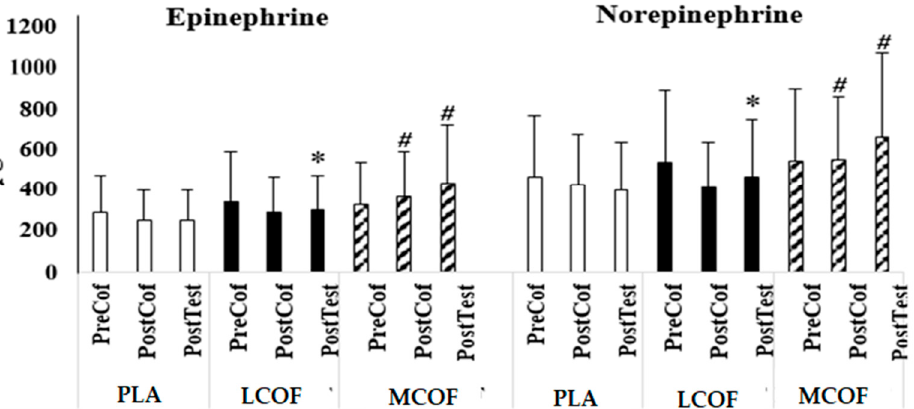
Figure 3. Blood epinephrine and norepinephrine concentrations measured at PreCof (Prior to coffee ingestion), PostCof (60 min after coffee ingestion), and Posttest (immediately after test protocol) with the ingestion of placebo (PLA) or 3 mg·kg − 1 of caffeine from coffee (LCOF) or 6 mg·kg − 1 of caffeine from coffee (MCOF). * : Significantly different from PLA; #: Significantly different from PLA and LCOF.